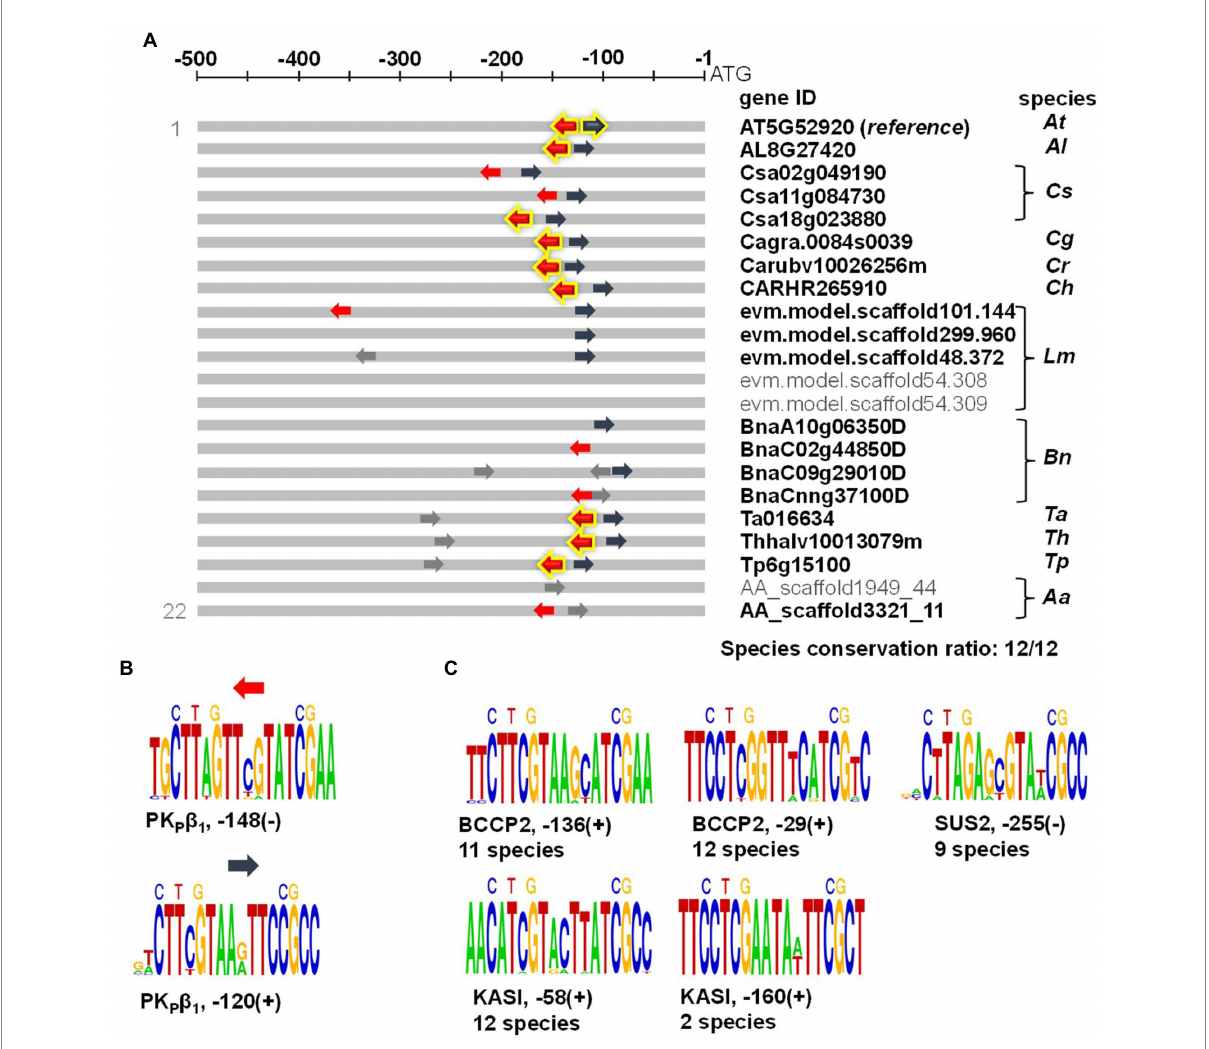
FIGURE 7 Conservation of the AW-box across 500 bp ortholog upstream regions (OURs). Sequence comparisons were made for 18 nc sequences (14 nc AW-box sites plus two nc adjacent on each side). (A) Each of the two AW-box sites upstream of AT5G52920 ( A. thaliana plastidic pyruvate kinase β 1 -subunit) is compared to all other detected sites with identical directionality (+/ − strand) in the OURs. The emboldened arrows represent the AW-sequence in A. thaliana , which in some cases are fully preserved in other species. For 15 or more base identities per 18 bases sequence length a conservation relation is given (red or dark blue color). Since pairwise conservation relations reach all the 12 species of this study, the A. thaliana AW-sites are considered to be conserved across all 12 species (Species conservation ratio = 12/12). (B) Sequence logos of the two conserved AW- box sites upstream of AT5G52920. (C) Sequence logos of the two conserved AW-box sites upstream of Biotin Carboxyl Carrier Protein 2 (BCCP2, AT5G15530), Ketoacyl-ACP Synthase I (KASI, AT5G46290) and sucrose synthase 2 (SUS2, AT5G49190). Number of species in which each AW site is conserved is given. All sequences shown in this figure can be found in Supplementary Table 9. Abbreviations: Aa, Aethionema arabicum ; At, Arabidopsis thaliana ; Al, Arabidopsis lyrata ; Bn, Brassica napus ; Cs, Camelina sativa ; Cg, Capsella grandiflora ; Cr, Capsella rubella ; Ch, Cardamine hirsuta ; Lm, Lepidium meyenii ; Th, Thellungiella halophila ; Tp, Thellungiella parvula ; Ta, Thlaspi arvense